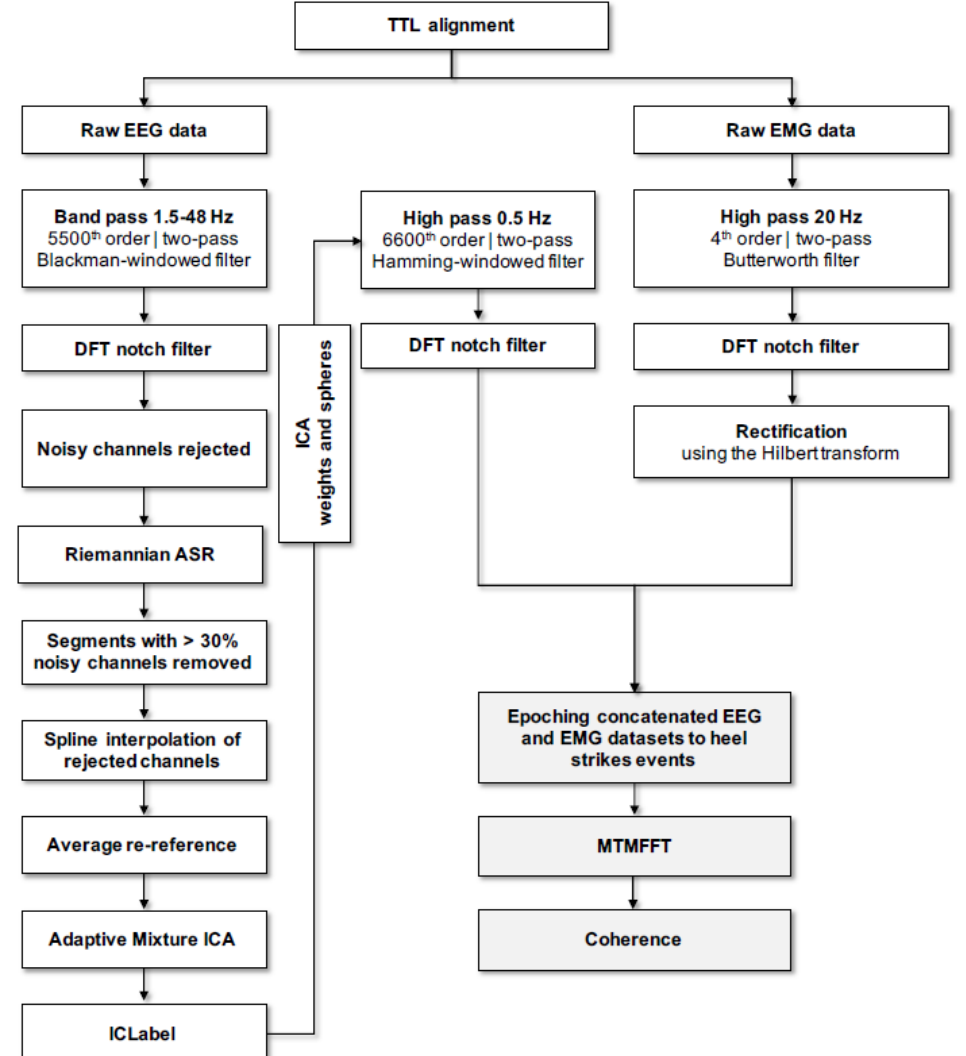
Figure 2. Overview of the pipeline adopted to perform data pre-processing and spectral analysis; Data pre-processing steps are depicted by the boxes, whereas spectral analysis steps are depicted by greyish boxes. TTL: Transistor-Transistor Logic; EEG: Electroencephalography; EMG: Electromyography; DFT: Discrete Fourier Transform; ASR: Artifact Subspace Reconstruction; ICA: Independent component analysis; MTMFFT: multitaper frequency